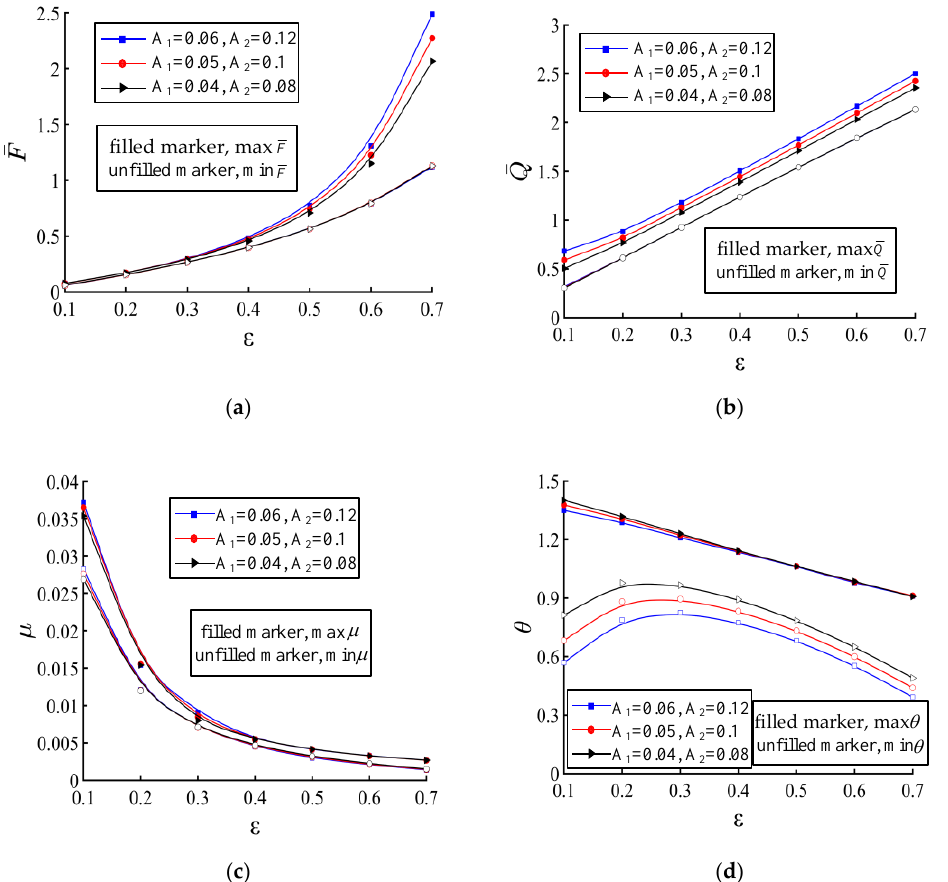
Figure 13. Variations of the maximum and minimum dimensionless bearing load capacity ( a ), dimensionless end leakage flow rate ( b ), friction coefficient ( c ) and altitude angle ( d ) with the eccentricity ratio under the same waviness number ( n 1 = 6, n 2 = 6) and a different waviness amplitude ratio.